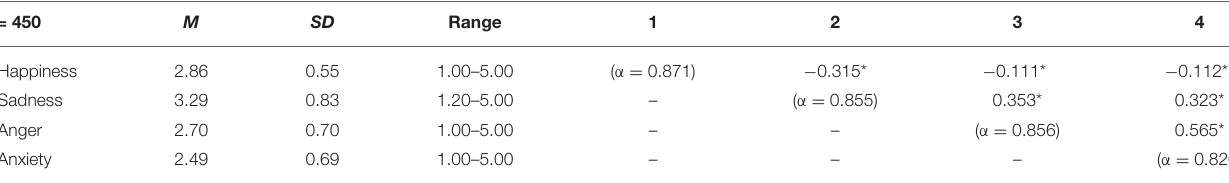
TABLE 5 | Descriptive statistics and internal consistency of and correlations between the four subscales of the Salzburg Emotional Eating Scale in study 3. n = 450 M SD